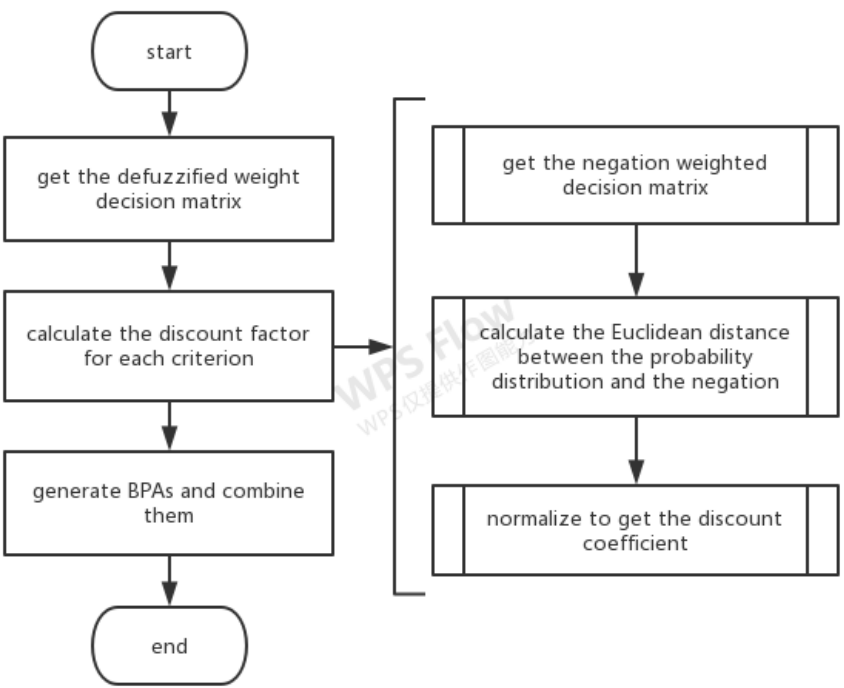
Figure 1. The procedure of proposed